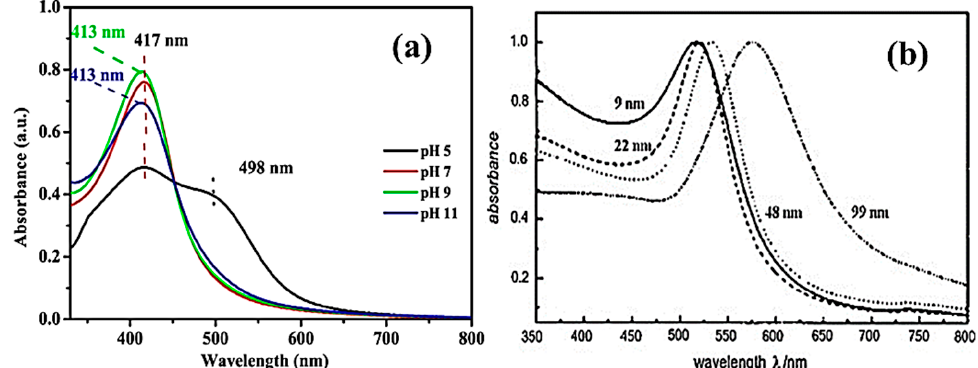
Figure 2. LSPR bands of the Au NPs with different sizes ( a ) SPR of Ag NPs, ( b ) SPR bands for Au NPs [34,35].